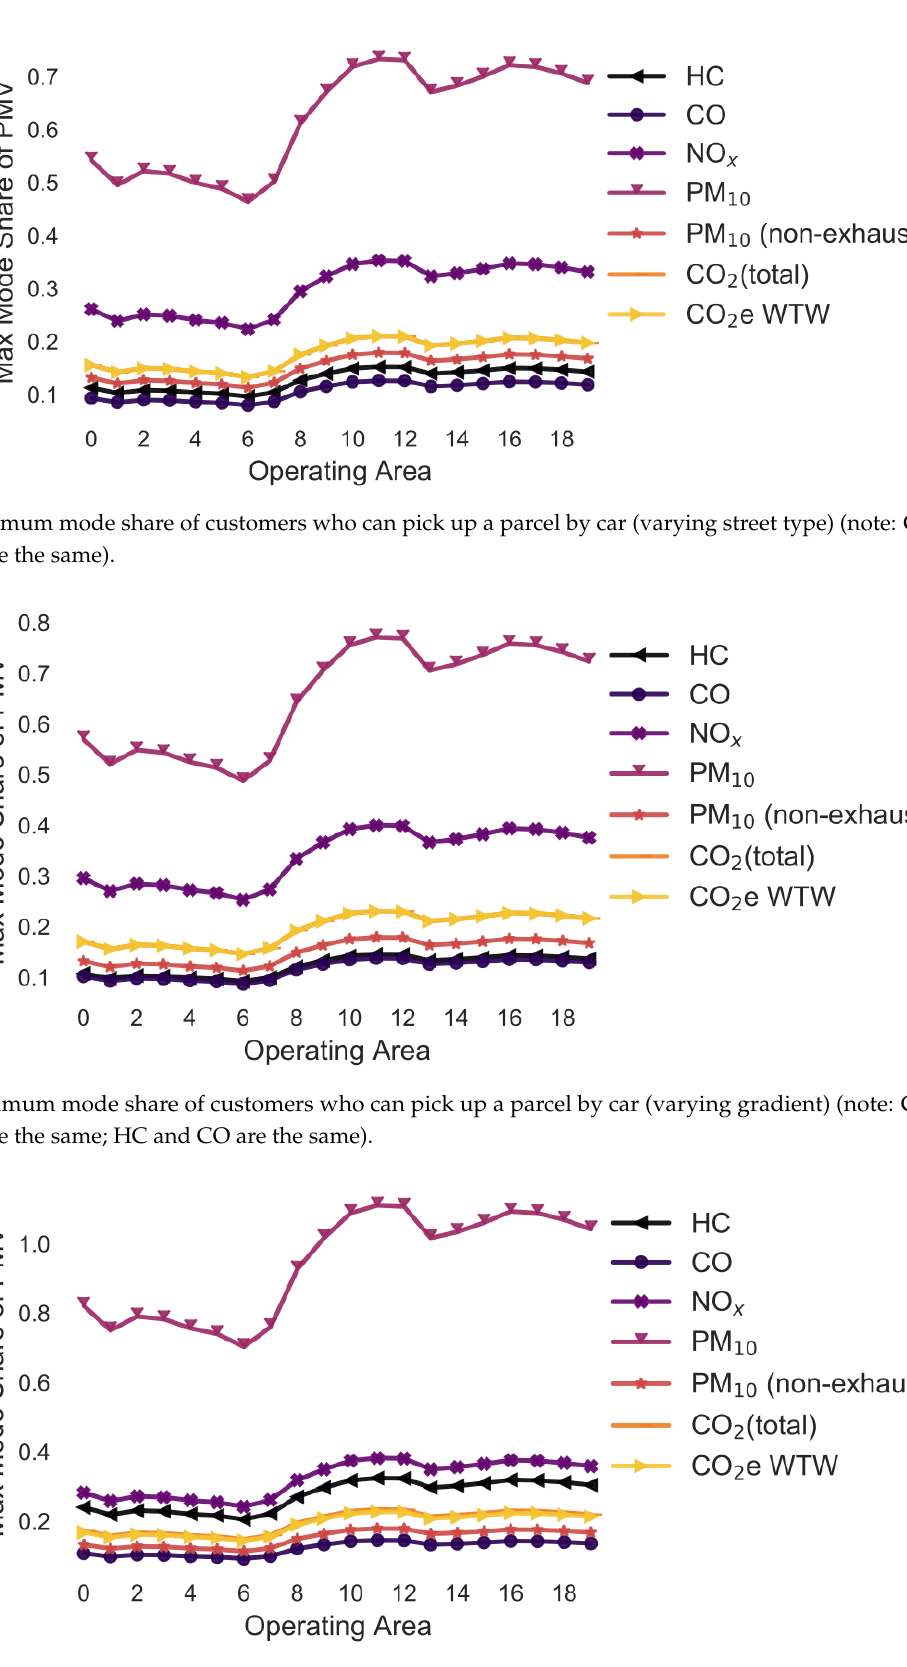
Figure 8. Maximum share of customers who can pick up a parcel by car (varying delivery vehicle stock age) (note: CO 2 (total), CO 2 e WTW and PM 10 (non-exhaust) are the same). Figure 9. Maximum share of customers who can pick up a parcel by car (average over operat- ing areas, varying delivery vehicle age) (note: PM 10 (non-exhaust), CO 2 (total) and CO 2 e WTW are the same).